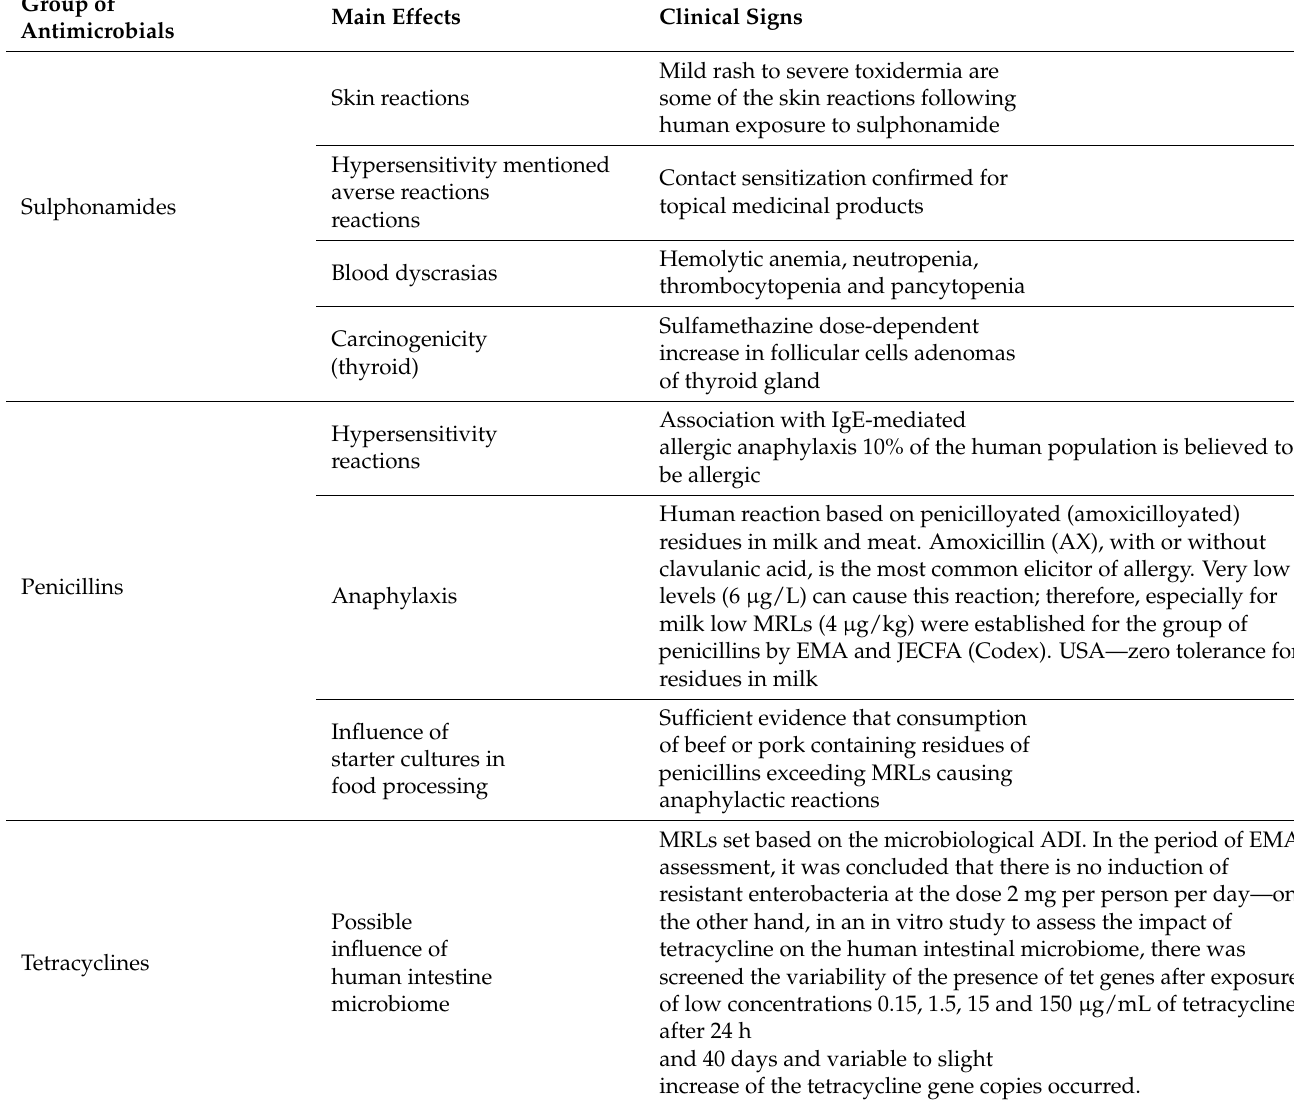
Table 5. Possible effects due to antibiotics in human.